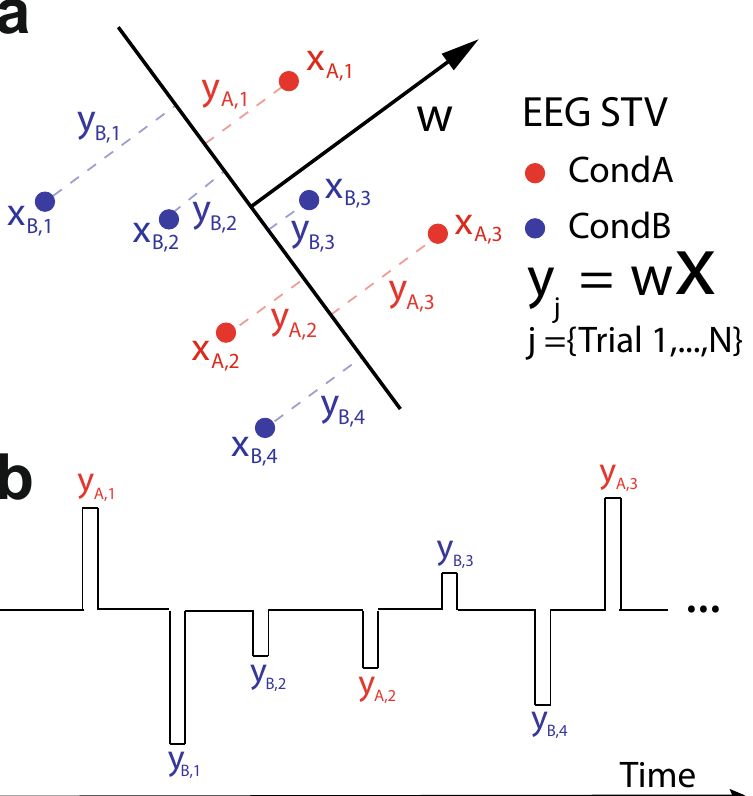
Figure 2. Single-trial discriminant analysis and EEG-informed fMRI regressors. ( a ) We used single-trial analysis of the EEG to perform binary discriminations between conditions of interest, here denoted as condition A and B (in red and blue respectively). We first estimated w , which is a linear weighting on the EEG sensor data ( X ) that maximally discriminates between the two conditions. This determines a task-related projection ( y )